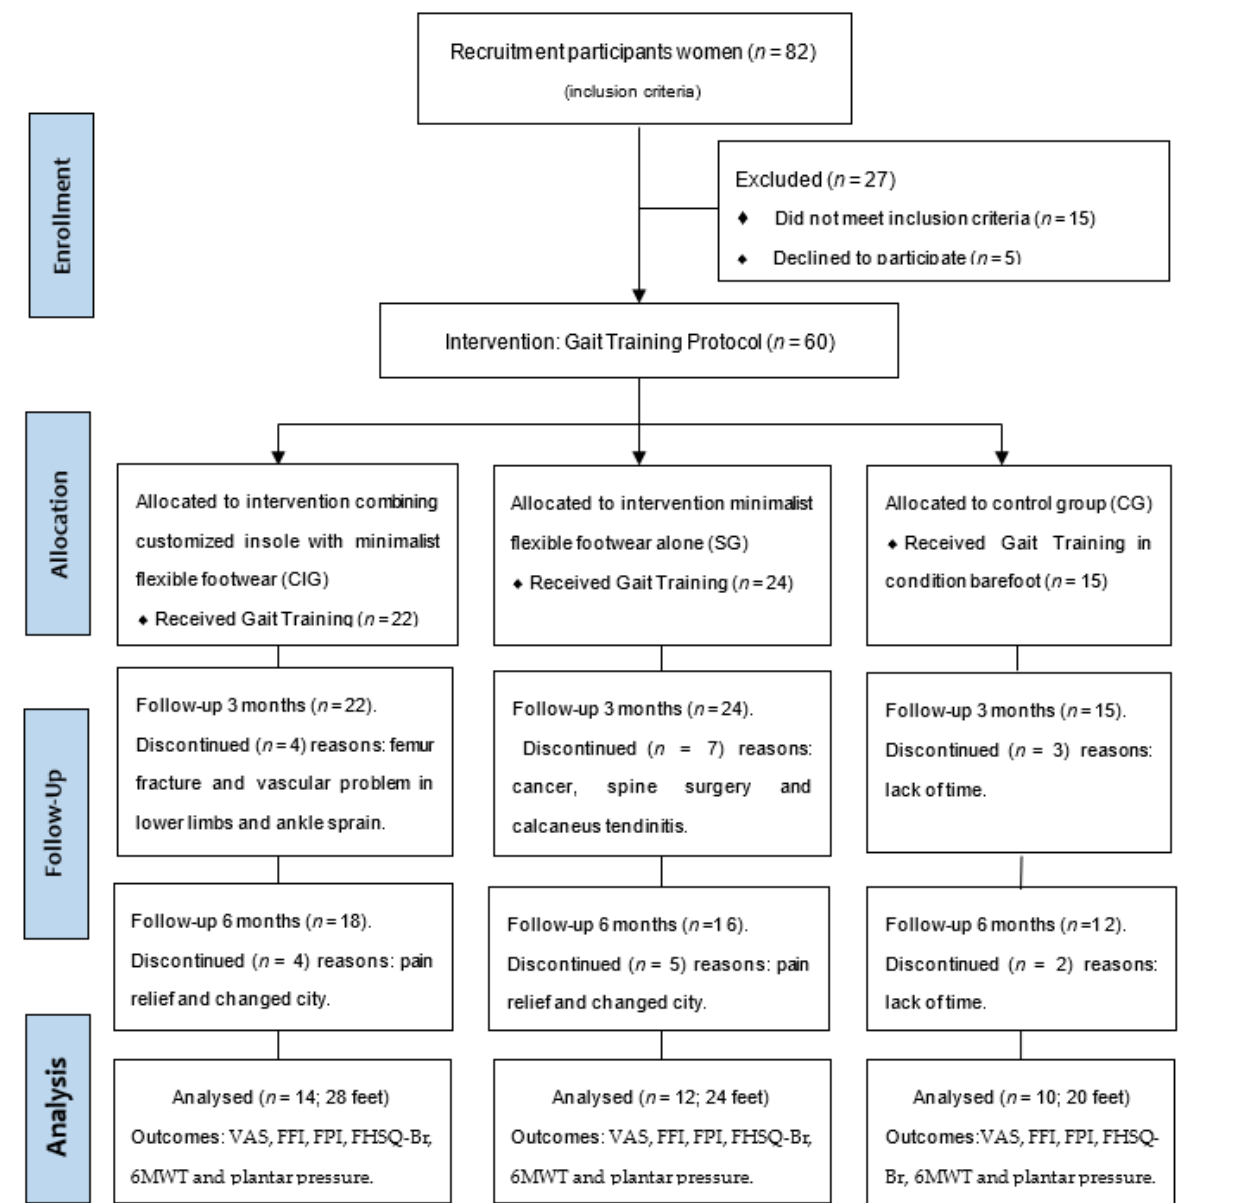
Figure 1. Flow Diagram of patients with plantar fasciitis to the clinical trial and measured outcomes.